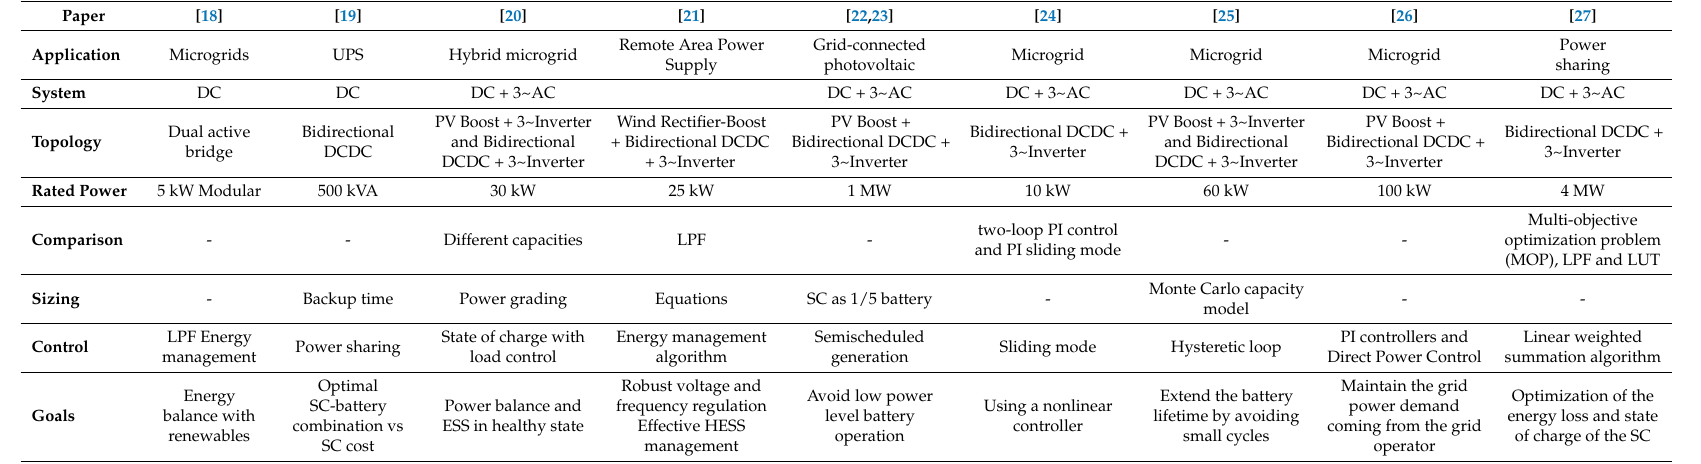
Table 2. Summary of HESS greater than 5 kW in the